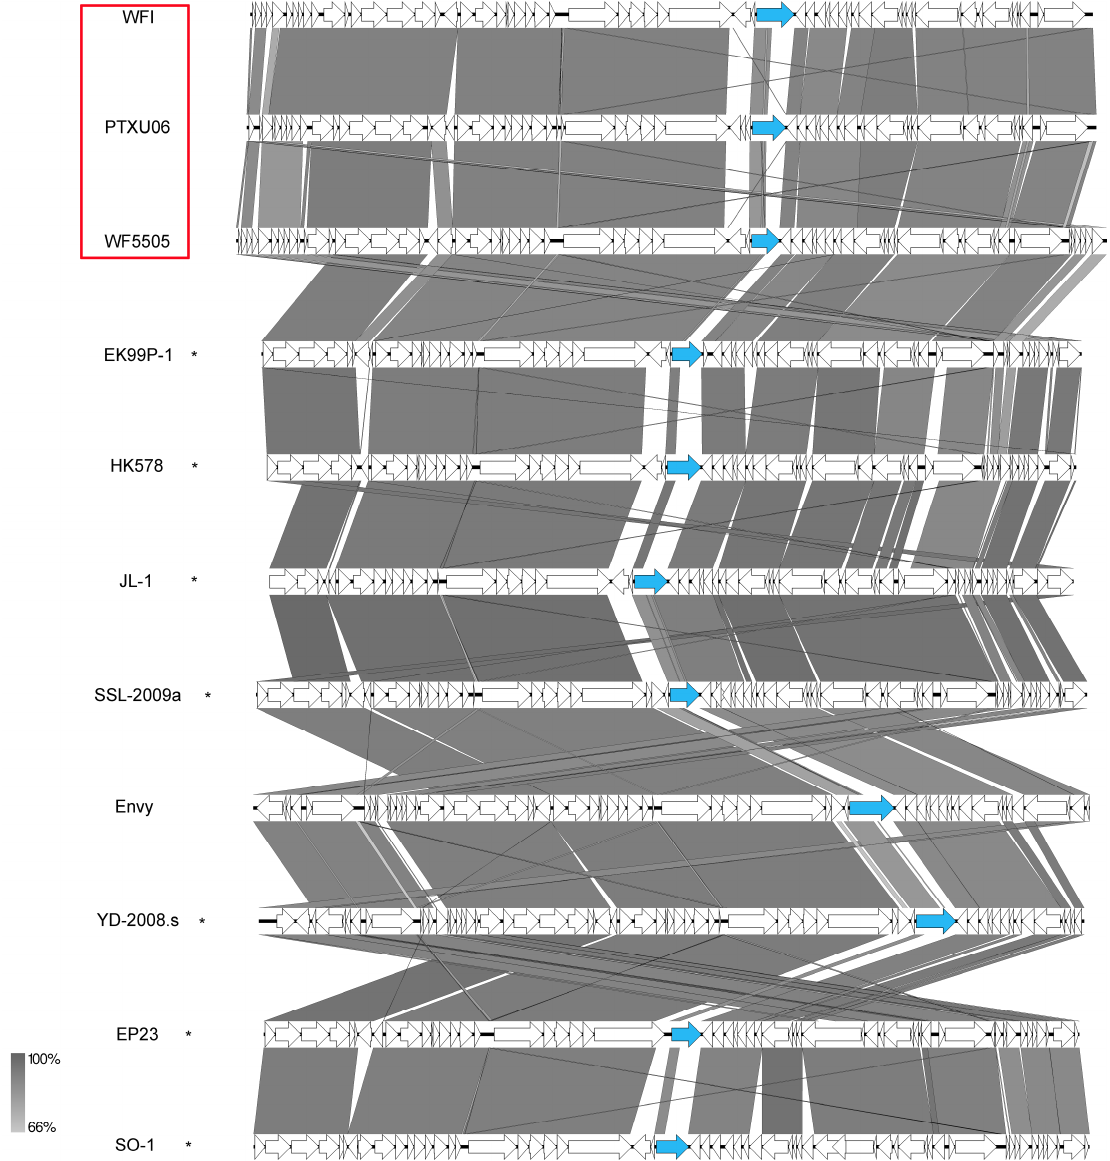
Figure 15. Synteny plot of phages WFIE160, WF5505, and PTXU06 and an overview of the genomic organization of selected HK578-like phages at the nucleotide level. The figure was generated with EasyFig. Asterisks indicate ICTV-classified species within the genus as Dhillonvirus . Isolates of this study are marked in